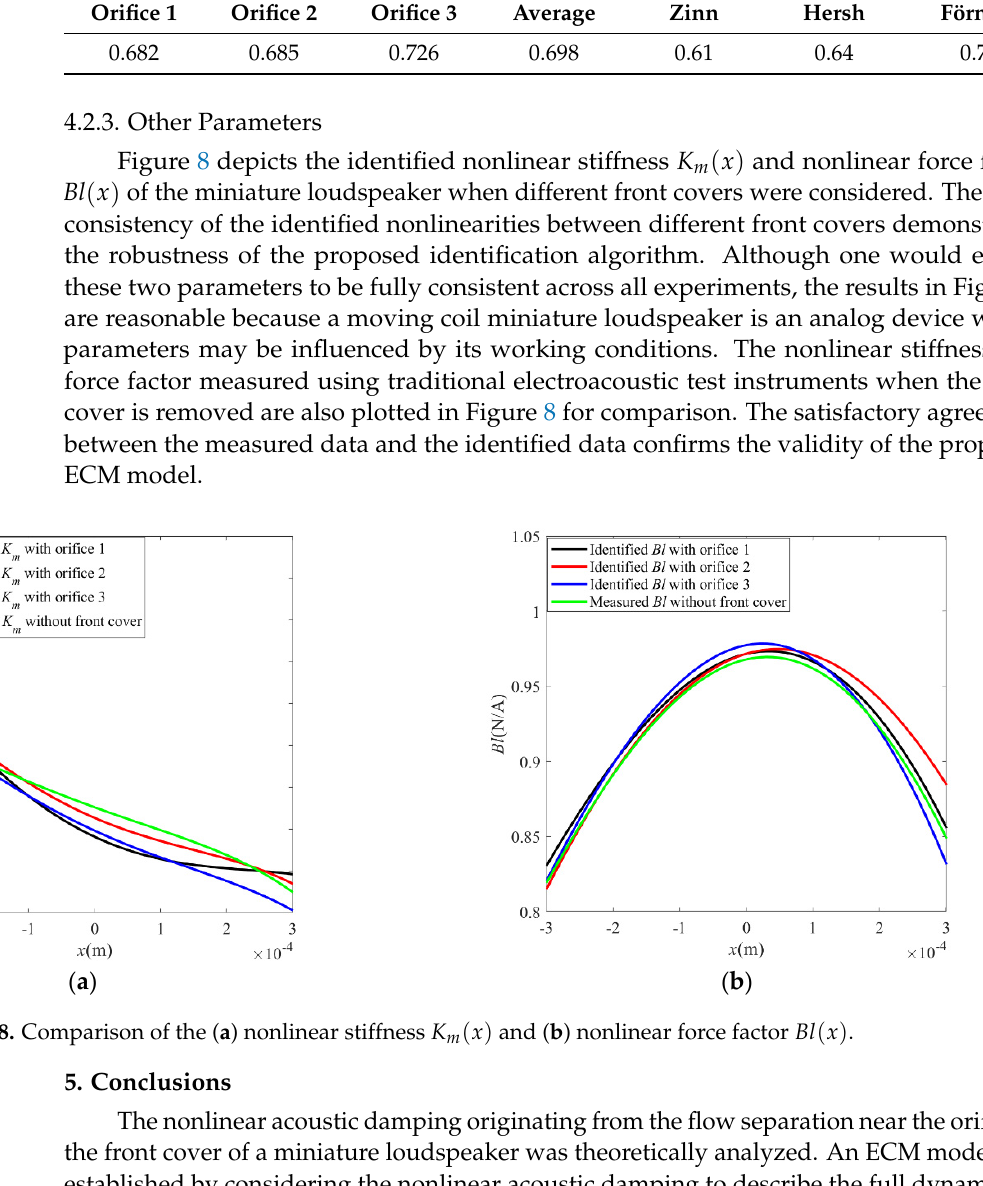
m ( x ) and ( b ) nonlinear force factor Bl ( x )